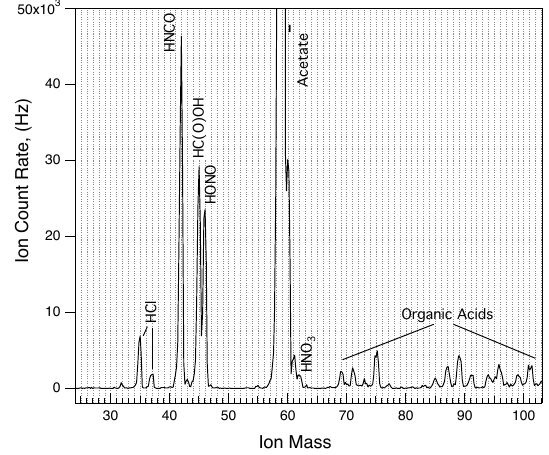
Fig. 3. A mass scan of Fire #64, a sample of pine litter and duff from Fort Benning, GA, acquired with no dilution, beginning at 4min after ignition. The spectrum was normalized so that the acetate ion signal was 10 6 counts.